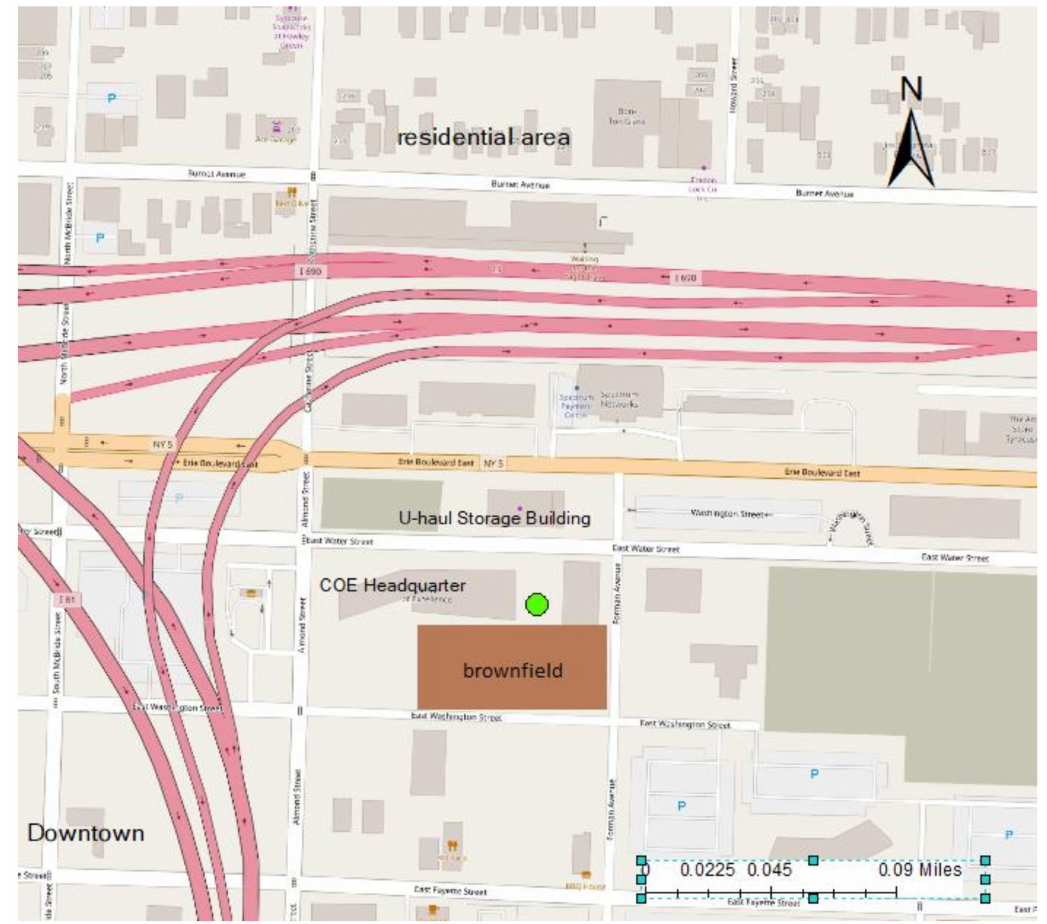
Figure 1. Sampling location of total gaseous mercury measurements at green circle in Syracuse, NY, USA. Interstate highways are shown in pink. The location of the former brownfield site is shown in